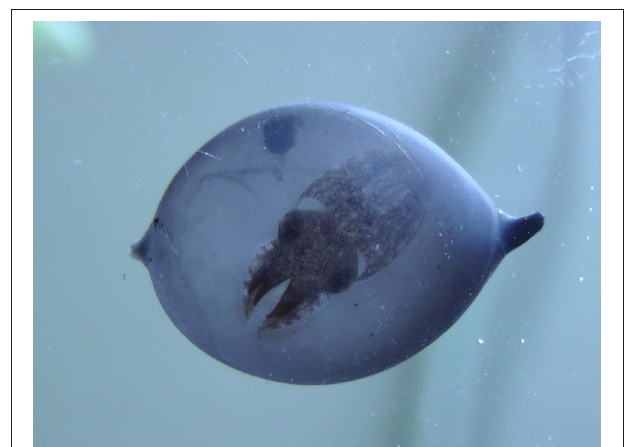
FIGURE 6 | Stage 30 embryo (less than 1 cm) showing a mottle-disruptive coloration inside the egg. It has also squirted ink; note the cloud of ink in the perivitellin fluid. Note that the embryo is seen from under through a peeled S. officinalis egg (photo C.E.